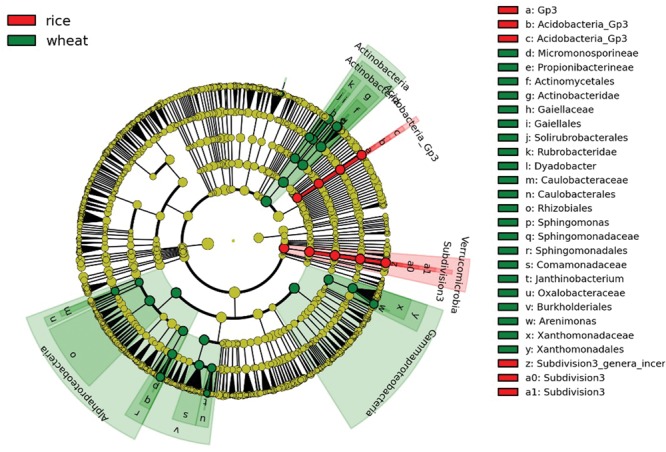
Cladogram indicating the phylogenetic distribution of bacterial lineages under wheat and rice rotations; lineages with LDA values higher than 2.5 are displayed. Differences are represented in the color of the most abundant taxa (red indicate rice rotation, green indicate wheat rotation, and yellow are non-significant). Each circle’s diameter is proportional to the given taxon’s relative abundance. Circles represent phylogenetic levels from domain to genus from the inside outwards.